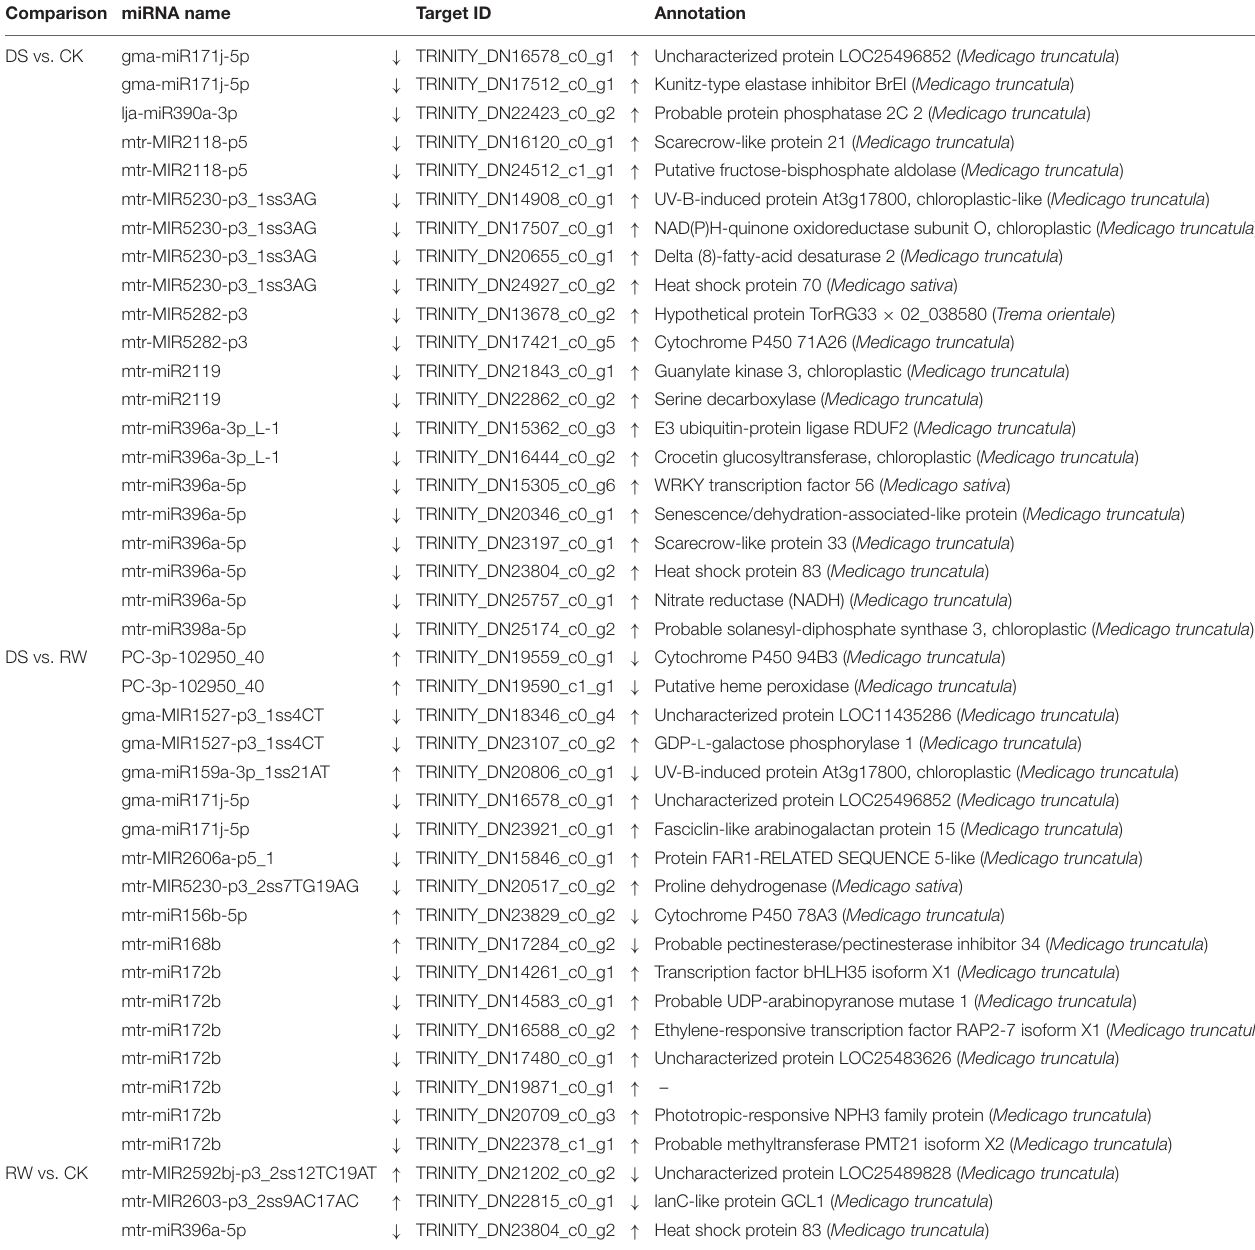
TABLE 7 | The miRNA-target gene pairs showed reverse expression patterns in the three comparison groups. Comparison miRNA name Target ID